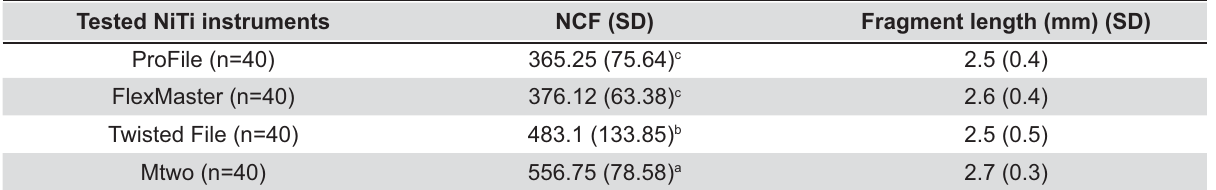
Table 1- The mean (SD) number of cycles to failure (NCF)* and fragment lengths in mm (SD) of tested NiTi instruments